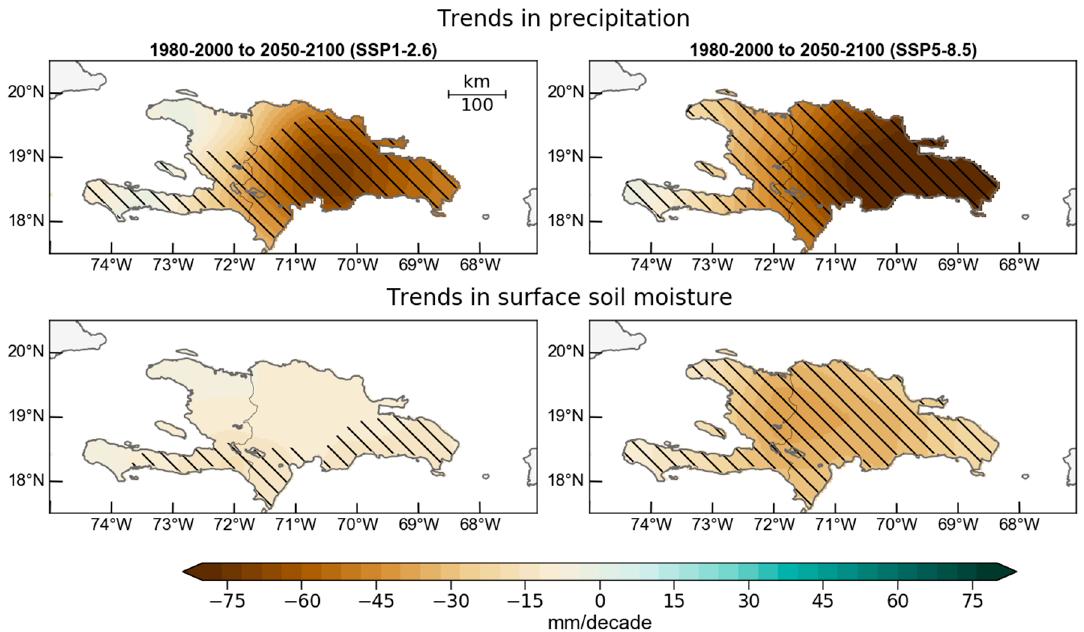
Figure 7. CMIP6 multimodel means of decadal trends in precipitation and surface soil moisture on Hispaniola Island. Hatching represents areas with statistically significant trends at the 95% interval. For display purposes, we bilinearly in- terpolated the results to a common 0.04° × 0.04° (4 km) horizontal resolution to match with our high-resolution products.